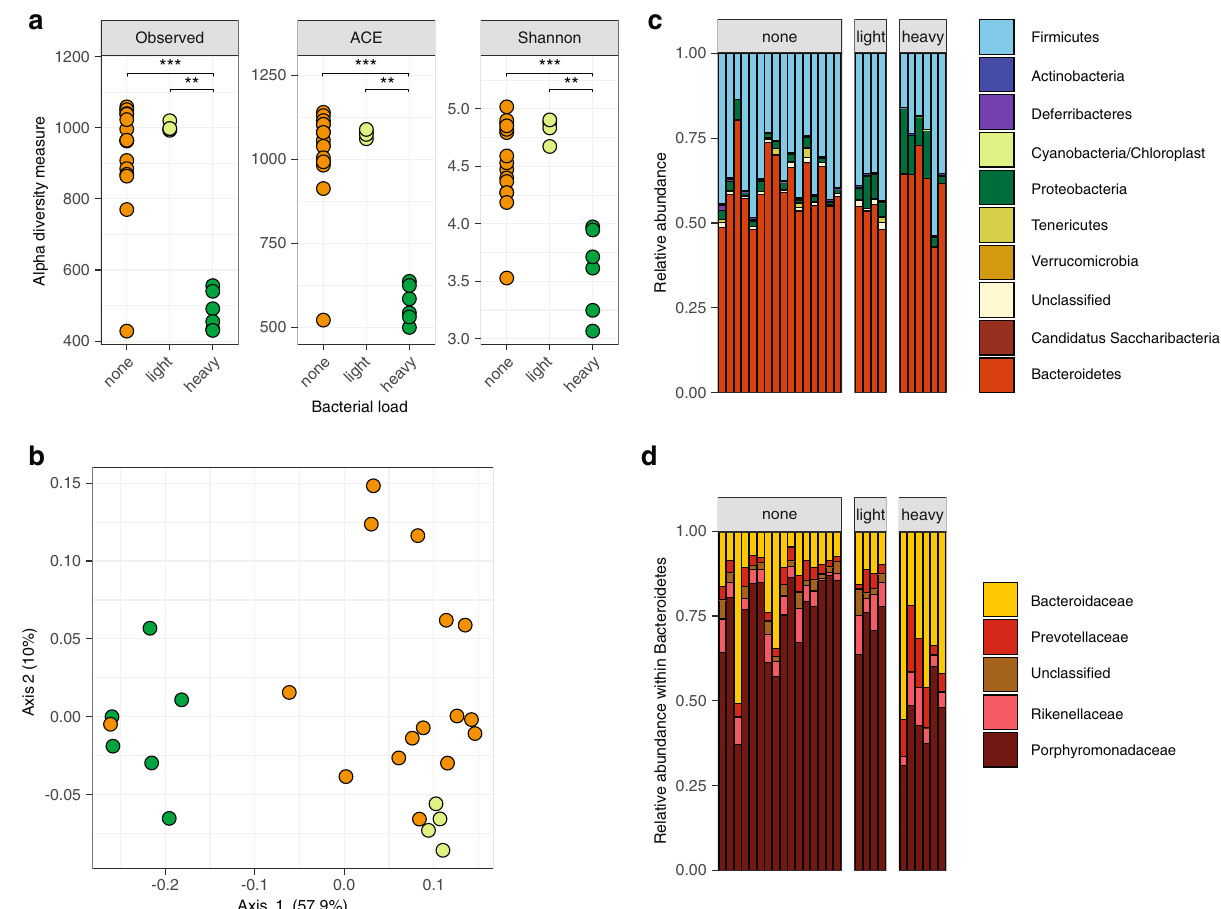
Fig. 6 Lm faecal carriage correlates with a speci fi c microbiota signature in mice. a Carriage groups differ in α -diversity, measured by observed species (left), abundance-based coverage estimate (middle) and Shannon index (right), (Observed: none vs. heavy: P = 0.00017, light vs. heavy: P = 0.014, ACE: none vs. heavy: P = 0.00026, light vs. heavy: P = 0.0095, Shannon: none vs. heavy: P = 0.0001, light vs. heavy: P = 0.0095). b β -diversity of mice microbiomes using MDS and Bray – Curtis distance. The colour indicates the carriage group (<100 CFU/g: none, 100 – 10 6 CFU/g: light, >10 6 CFU/g: heavy). All groups differed in composition (PERMANOVA overall P = 0.001, heavy/none P = 0.006, heavy/light P = 0.0075, light/none P = 0.031, with Benjamini – Hochberg correction). Light carriers were more homogeneous than other groups (permutation test for homogeneity of multivariate dispersion, heavy/none, P = 0.246, heavy/light P = 0.0160, light/none P = 0.0193, with Benjamini – Hochberg correction) c Microbiota composition of mice from Fig. 2c at phyla level and d family level within the Bacteroidetes phylum. Statistical comparison performed with two-sided Wilcoxon rank-sum test. * P < 0.05, ** P < 0.01, *** P < 0.001, **** P <